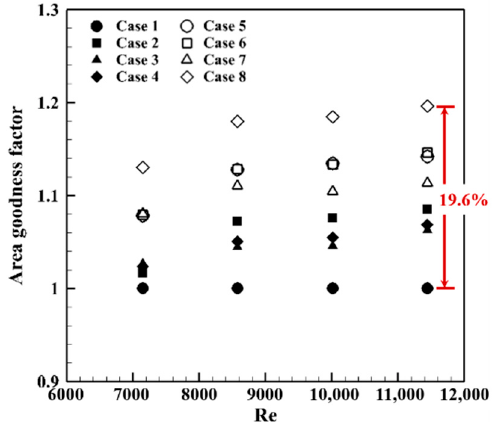
Figure 12. Area goodness factor with Reynolds number.